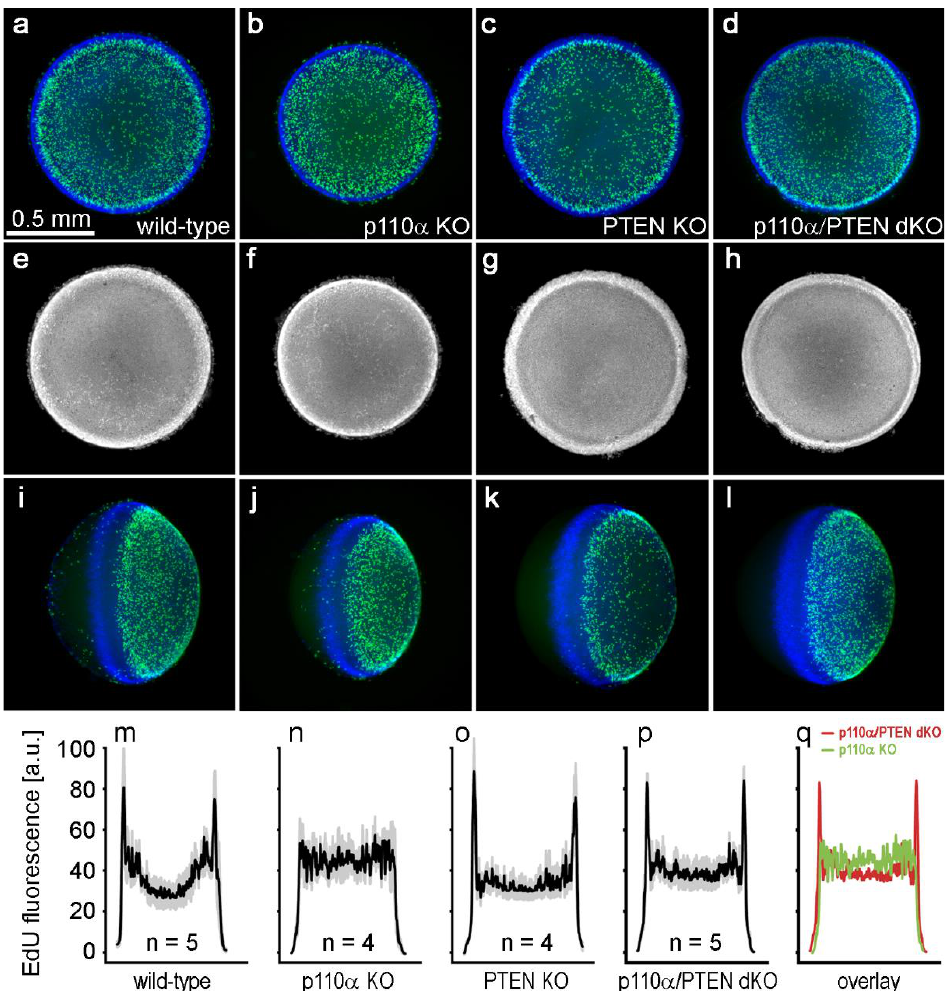
Figure 4. Double p110 α /PTEN knockouts lacked the postnatal proliferation defect of single p110 α knockout lenses. Postnatal day 0 lenses from wild type ( a , e , i ) , single p110α KO ( b , f , j ), single PTEN KO ( c , g , k ), and p110α/PTEN dKO ( d , h , i ) mice were stained with EdU (green, a – d , i – l ) and Hoechst (blue, a – d , i – l , or gray, e – h ). Z-stack images were generated looking onto the epithelial surface ( a – d ), or onto the lens edge ( i – l ). Grayscale images of Hoechst-stained nuclei were also displayed to verify the overall integrity of the lens epithelium ( e – h ). EdU labeling showed that the distribution of proliferating cells in the p110 α /PTEN dKO lenses was similar to that of wild-type, or single PTEN KO lenses, with the highest signal in the equatorial germinative zone. Plots of mean values of line scans (black lines, ± the SEM gray bars) of EdU fluorescence taken along the lens diameter ( m – q ) confirmed that the p110 α /PTEN dKO lenses had recovered peak proliferation in the equatorial germinative zone, which was greatly reduced from single p110α KO lenses [13] . n = 4 – 5 lenses per genotype.